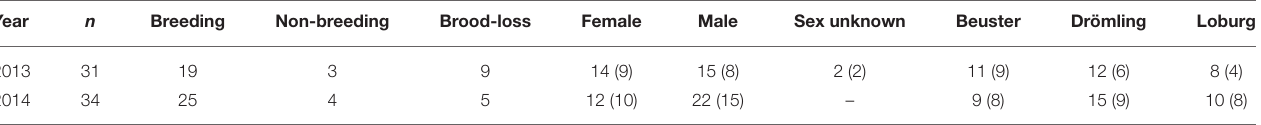
TABLE 1 | Number of individuals in observation